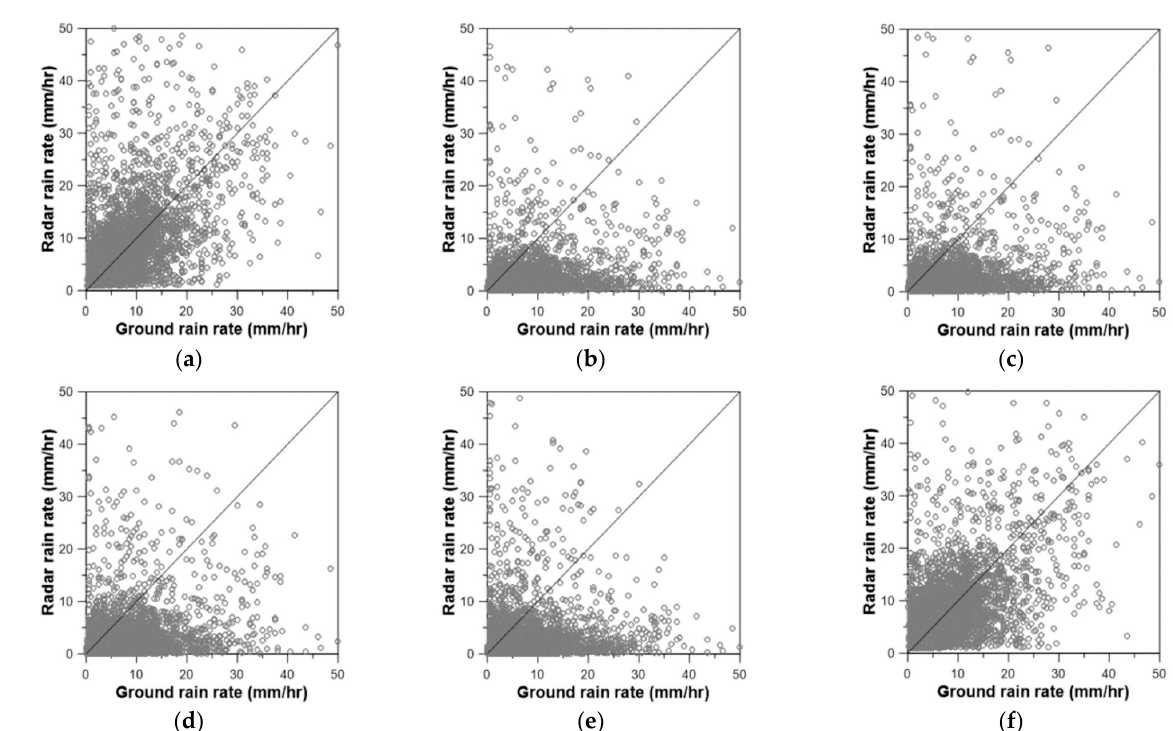
Figure 11. Same as Figure 9, but for all 10 rain gauge stations of four storm events: ( a ) EKF, ( b ) Chandrasekar and Bringi (1988) [41], ( c ) Chandrasekar et al. (1990) [43], ( d ) Lee (2006) [48], ( e ) Kwon et al. (2015) [51], ( f ) LSM.